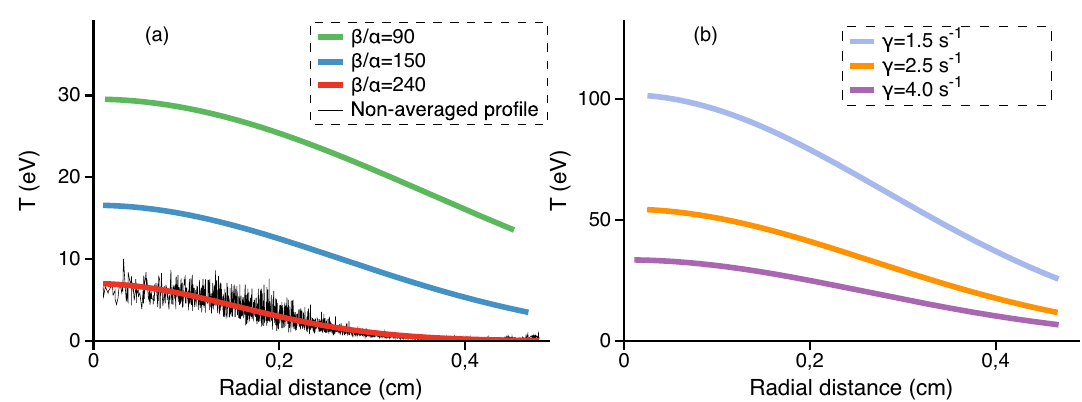
Figure 5. The radial profiles of in-plane kinetic temperature in the dusty plasma structure for different ( a ) values of β when γ is fixed and equals 7.6 s − 1 ; ( b ) values of γ when β/α is fixed and equals 150. Parameters of the MD and self-consistent wake potential calculations are Q